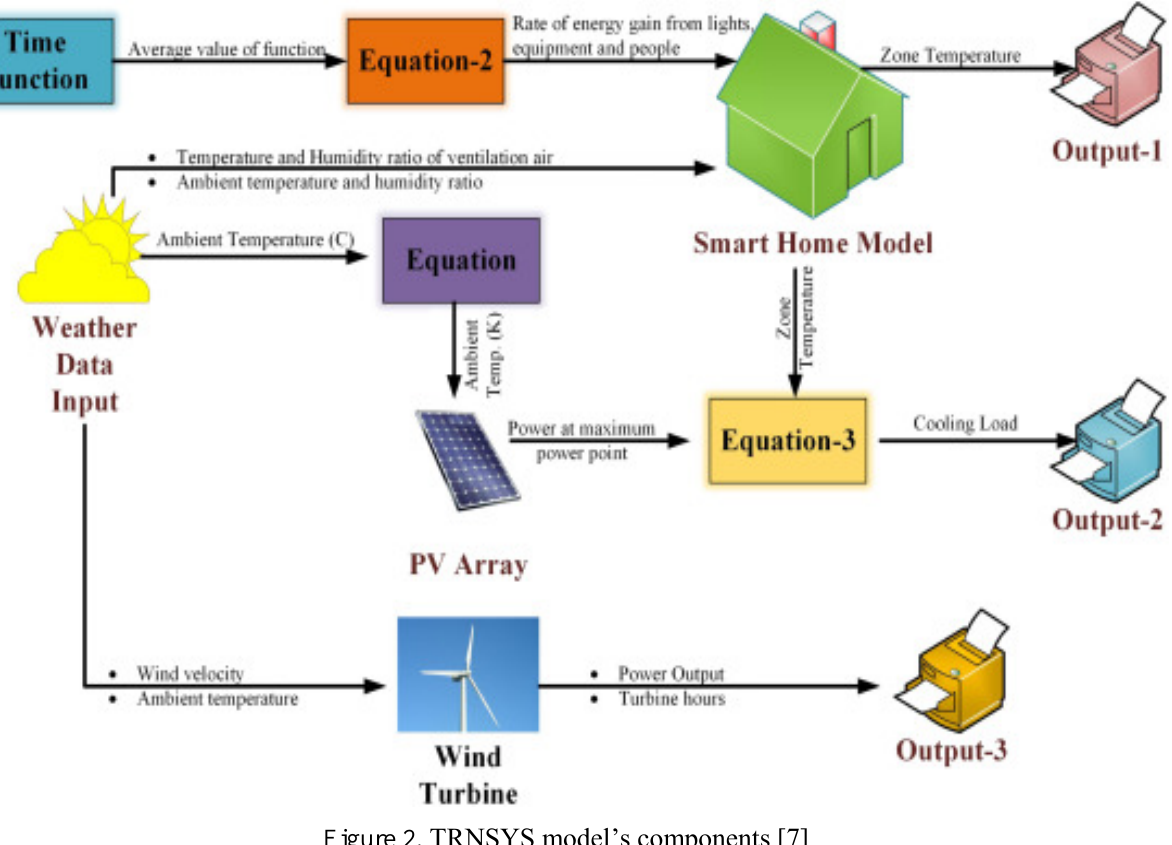
Figure 2. TRNSYS model’s components